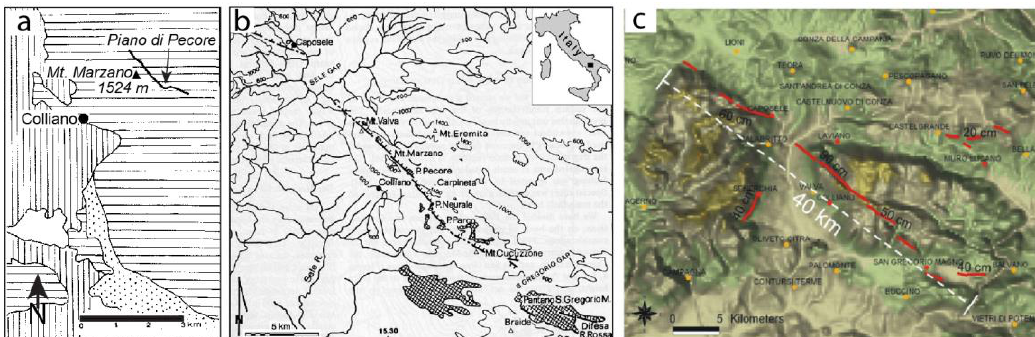
Figure 6. ( a ) Post-eventum mapping of the 1980 Irpinia earthquake surface faulting in the Mt. Marzano peak—Piano di Pecore plain area (modified from Cinque et al. [18]). ( b ) Mapping of the 1980 Irpinia earthquake coseismic surface ruptures from [12]. ( c ) Distribution of the 1980 Irpinia earthquake coseismic surface faulting, after [10,12,14,18,19,101,102] (from Serva et al. [15], modified).